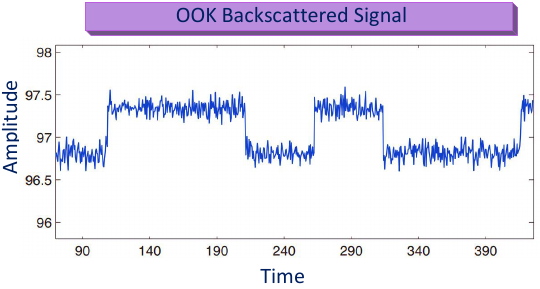
Figure 18. Amplitude modulation for BackCom.